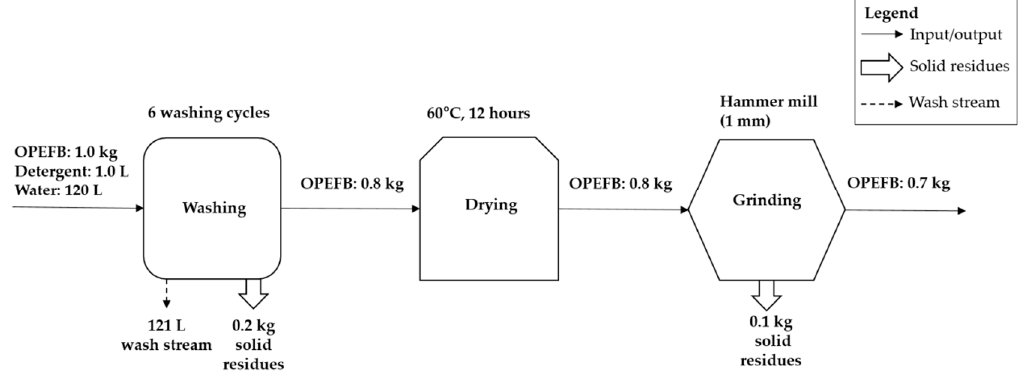
Figure 1. Mass balance diagram of the oil palm empty fruit bunch (OPEFB) preparation process.